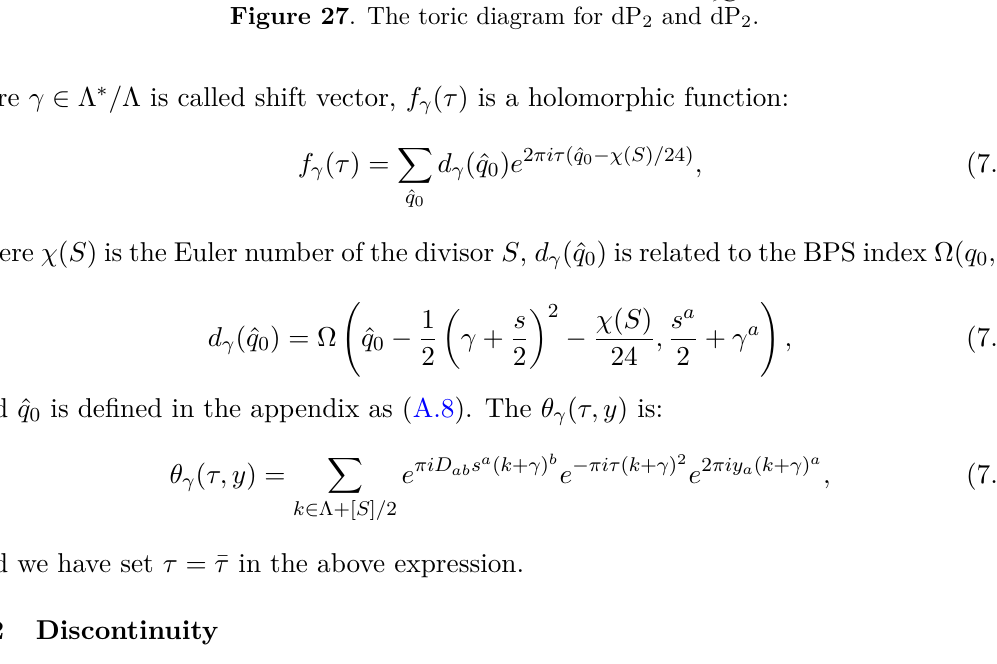
Figure 27 . The toric diagram for dP 2 and f dP 2